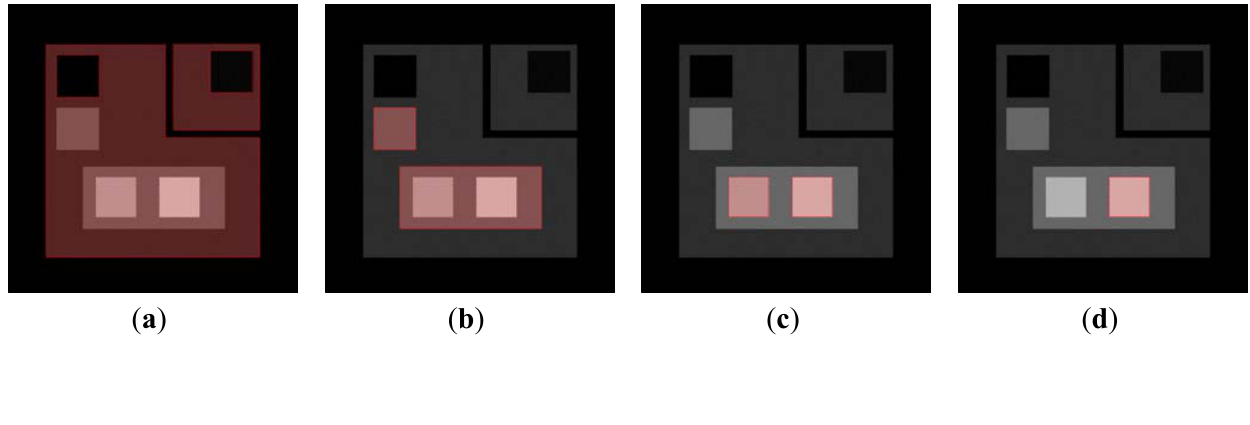
Figure 6. Results of a synthetic image with 5% uniform noise. ( a ) Contour 1 after 3 iterations of (14). ( b ) Contour 2 after 7 iterations. ( c ) Contour 3 after 7 iterations. ( d ) Contour 4 after 7